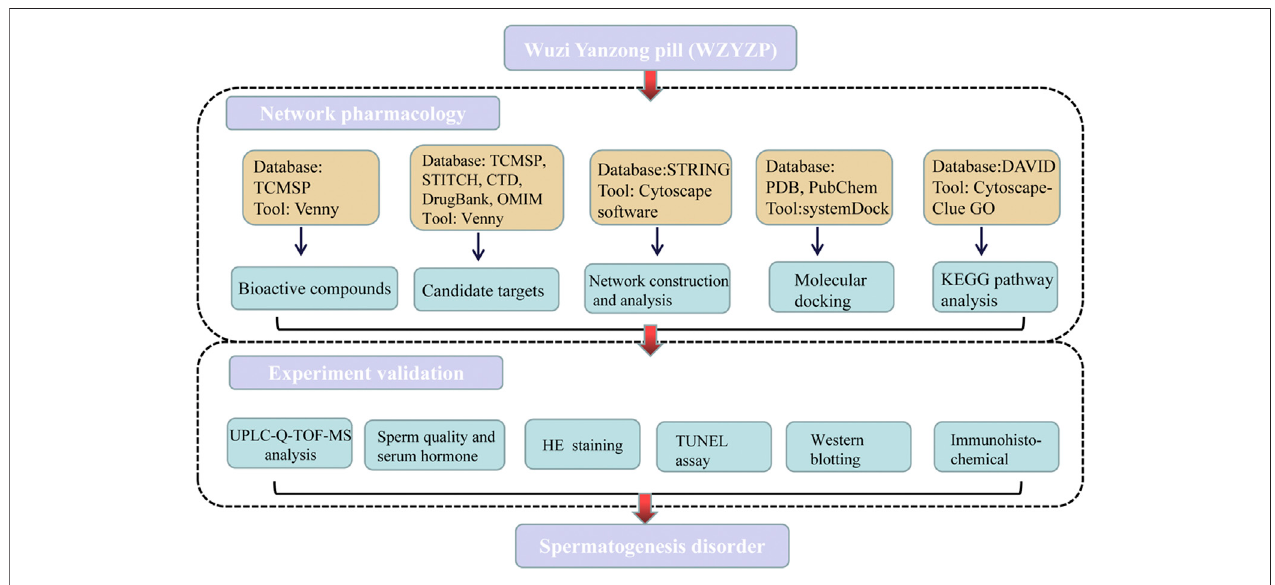
FIGURE 1 | The detailed fl ow chart of the study